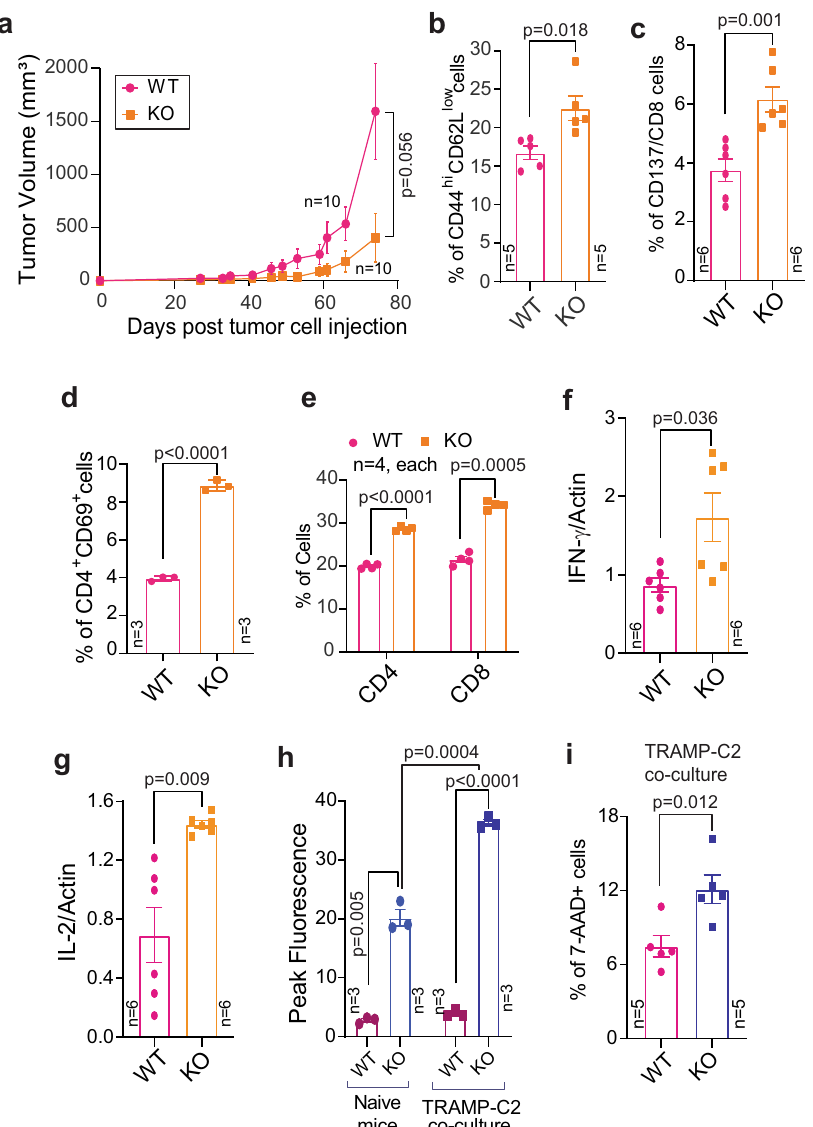
Fig. 4 | ACK1 negatively regulates the TCR activation diminishing T cell response.a TRAMP-C2cellswereimplantedsubcutaneouslyin6-to8-week-oldWT and Ack1 KO male mice and tumor volumes were measured with calipers ( n =10 mice in each group). Splenocytes were isolated from WT and Ack1 KO mice implanted with TRAMP-C2 cells. Flow cytometry analysis was performed to assess CD44 hi CD62L low on CD8 gated population ( b ) ( n =5 mice in each group); CD137 on CD8gatedpopulation ( c ) ( n =6 miceineachgroup);and CD69 expressiononCD4 gatedpopulation ( d )( n =3miceineachgroup). e Lymphocytesweredrained from lymph nodes of WT and Ack1 KO mice implanted with TRAMP-C2 cells. Flow cytometry analysis was performed to assess CD4 and CD8 populations ( n =4